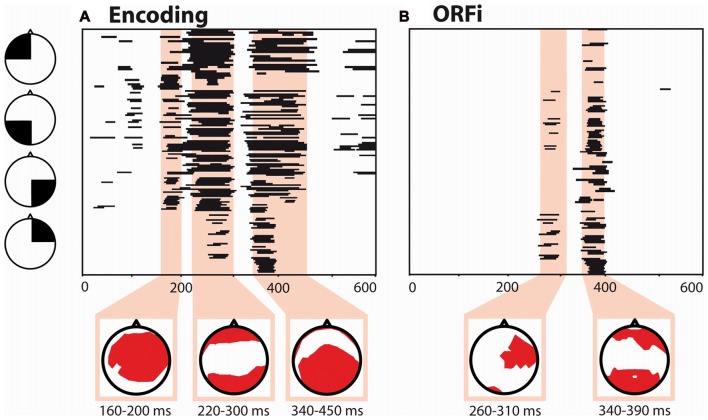
Global waveform analysis. Electrode- and time-wise global waveform analysis for the Encoding condition and ORFi condition displayed according to scalp position (black triangles). (A) Main effects in the one-way repeated measure ANOVA (rmANOVA) with factor Stimulus (New1, OneBack1, N-Back1). (B) Interactions in the the 2 × 2 rmANOVA with factor Stimulus (New, Ten) and Run (1,2). Black lines indicate significant effects (p < 0.01 for ≥20 ms). Electrodes with significant effects are displayed in red.